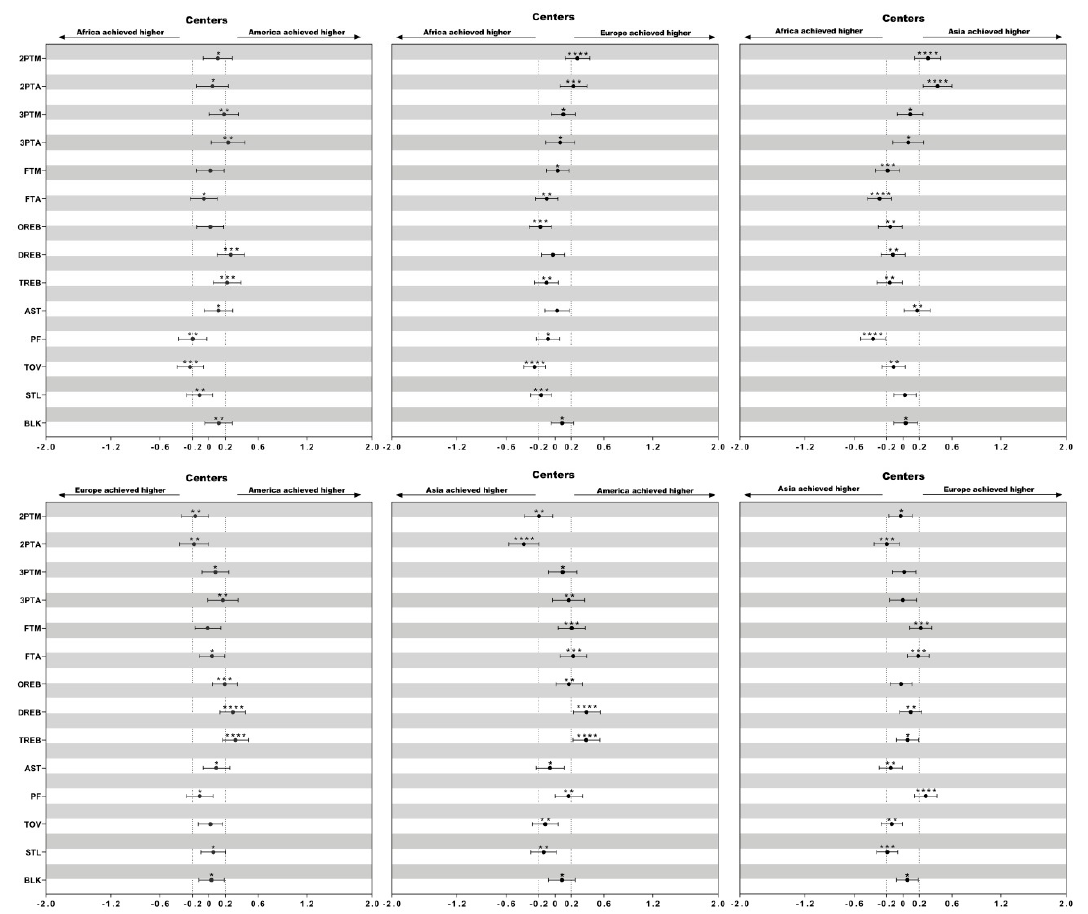
Figure 1. Standardized differences of technical performances in centers among different continental championships. Bars present 90% confidence intervals. Asterisks indicate the likelihood for the magnitude of the true difference as follows: * possible; ** likely; *** very likely; **** most likely. Asterisks located in the area between − 0.2 and 0.2 denote for trivial differences.